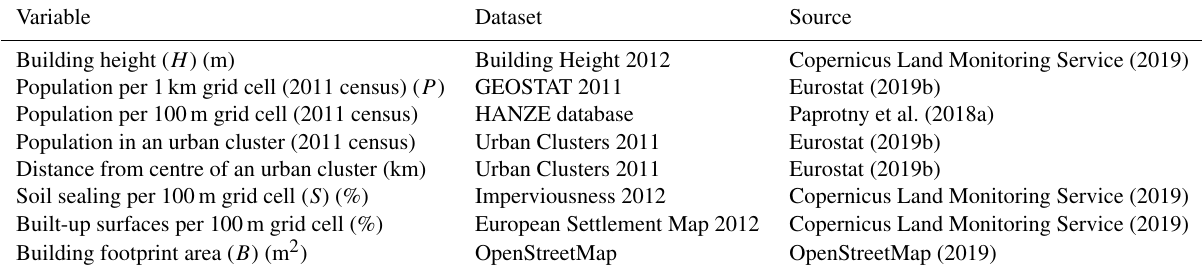
Table 1. Variables considered for the building height prediction model. Abbreviations are shown for variables included in the final model (Fig.